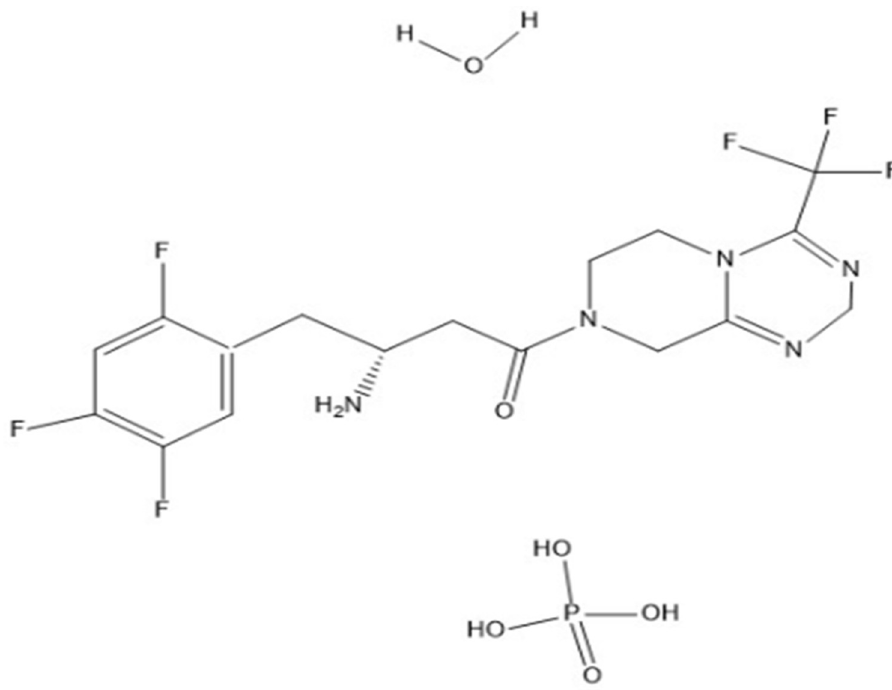
Fig 1. Chemical structure of